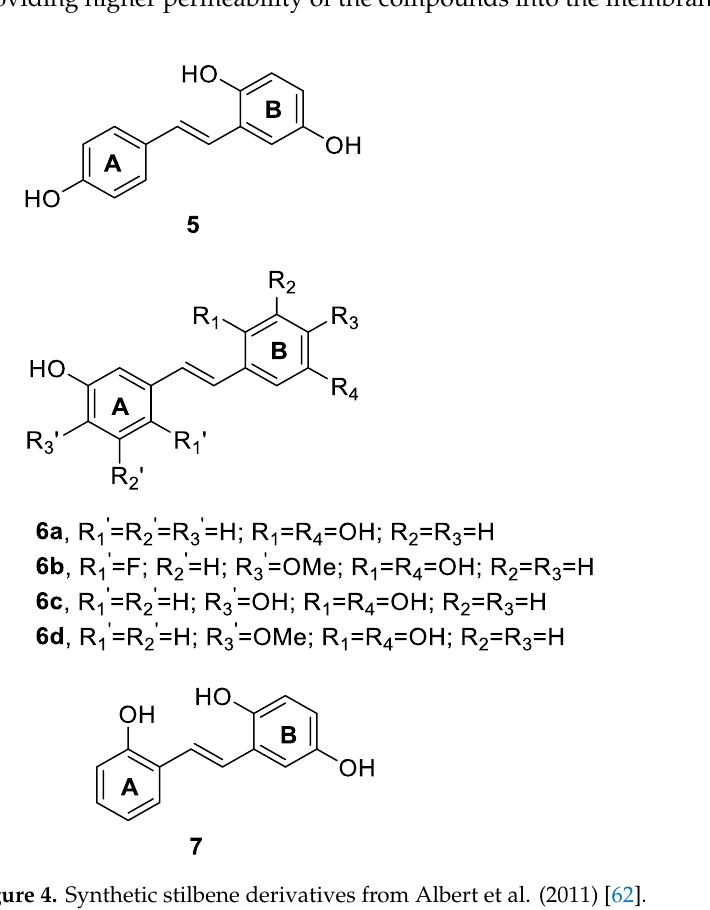
Figure 4. Synthetic stilbene derivatives from Albert et al. (2011) [62].